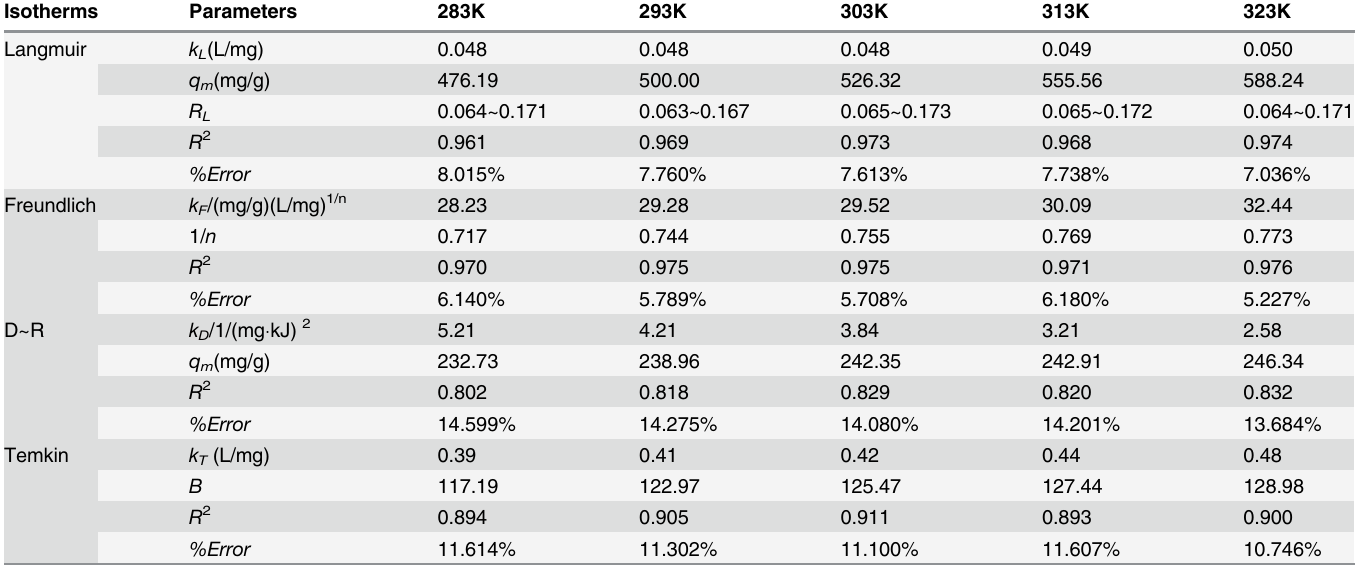
Table 2. Parameters of Langmuir, Freundlich, D-R and Temkin isotherm model equations.